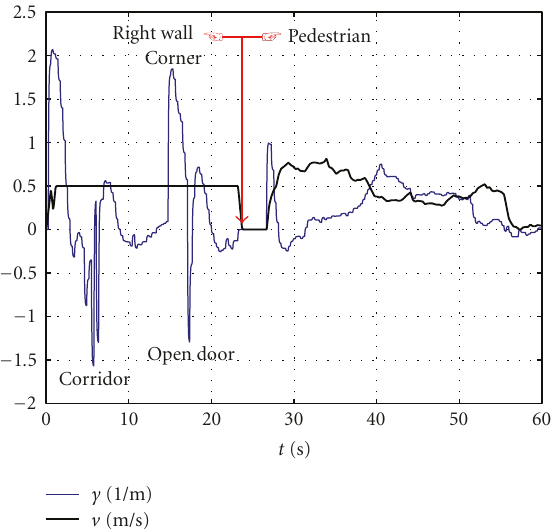
Figure 12: Curvature and speed of Auriga- α when following a wall and a person.